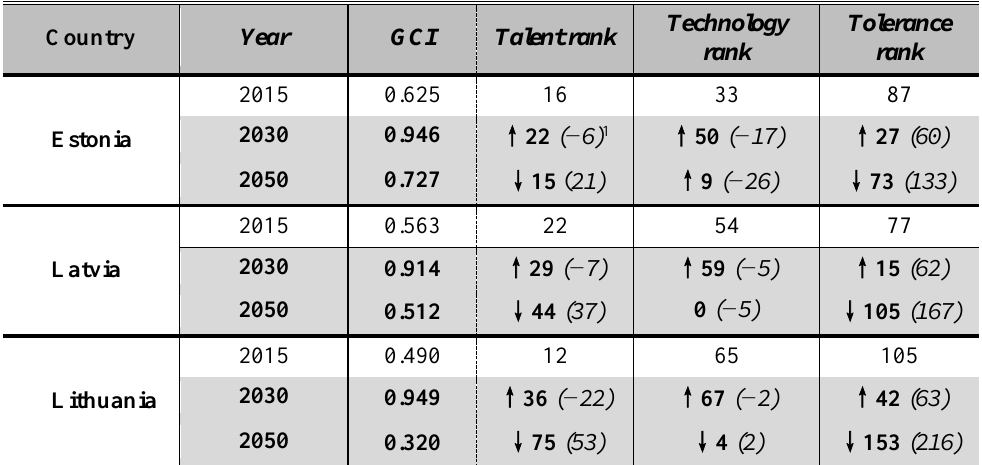
Technology Tolerance rank rank